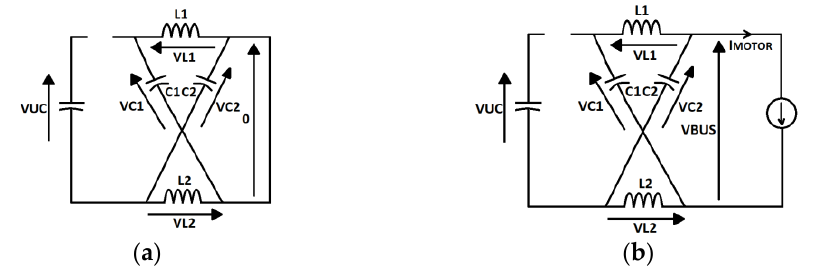
Figure 3. Equivalent circuit of a ZSI: ( a ) Shoot-through state; ( b ) non-shoot-through state.